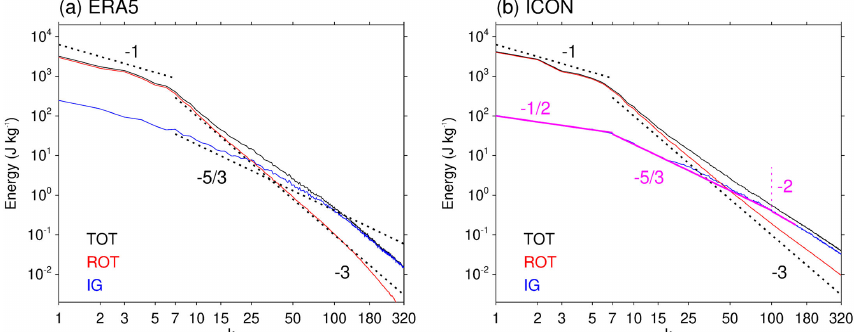
Figure 7. (a, b) Energy spectra as a function of zonal wave number from MODES applied to (a) ERA5 and (b) ICON. The (black) total energy spectrum is decomposed into (red) ROT modes and (blue) IG modes. Dashed black lines show spectral slopes of k − 1 , k − 5 / 3 , and k − 3 ; magenta lines in panel (b) show k − 1 / 2 , k − 5 / 3 , and k − 2 , where the transition between k − 5 / 3 and k − 2 is at k = 100 and marked by a thin vertical magenta